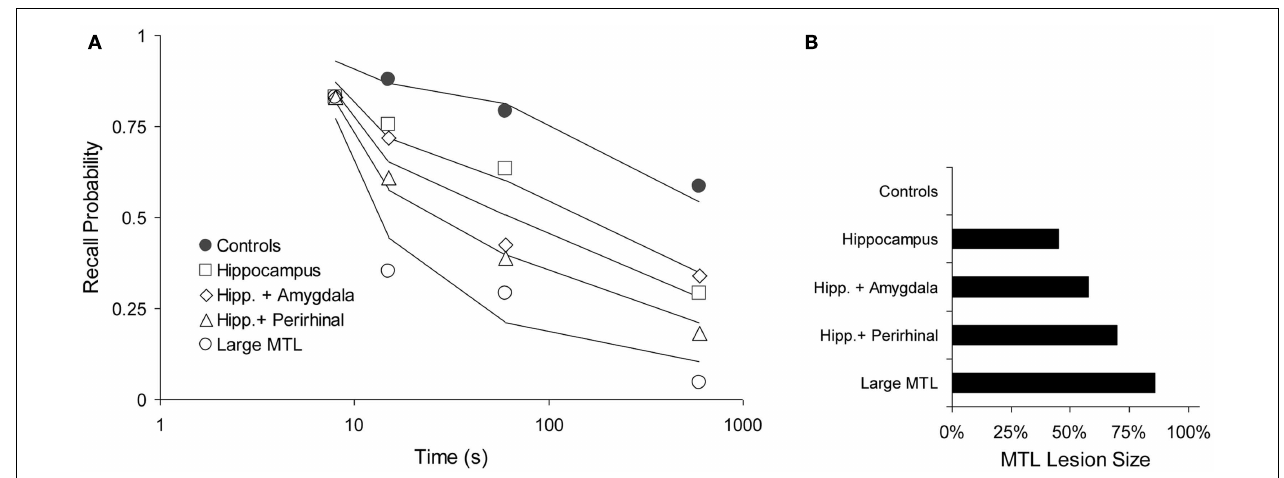
of delay period (logarithmic time scale). (B) Relative, functional lesion sizes in the medial temporal lobe (MTL), derived from the working-memory-to-MTL learning rates (see text). Here, 100% would be a full, functional